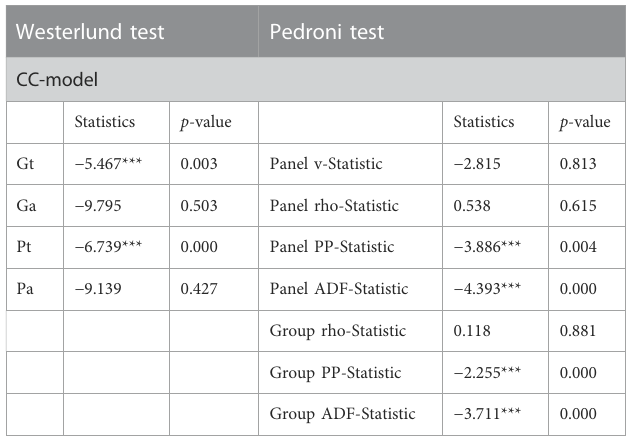
TABLE 5 Panel cointegration test results from Westerlund (2007) and Pedroni